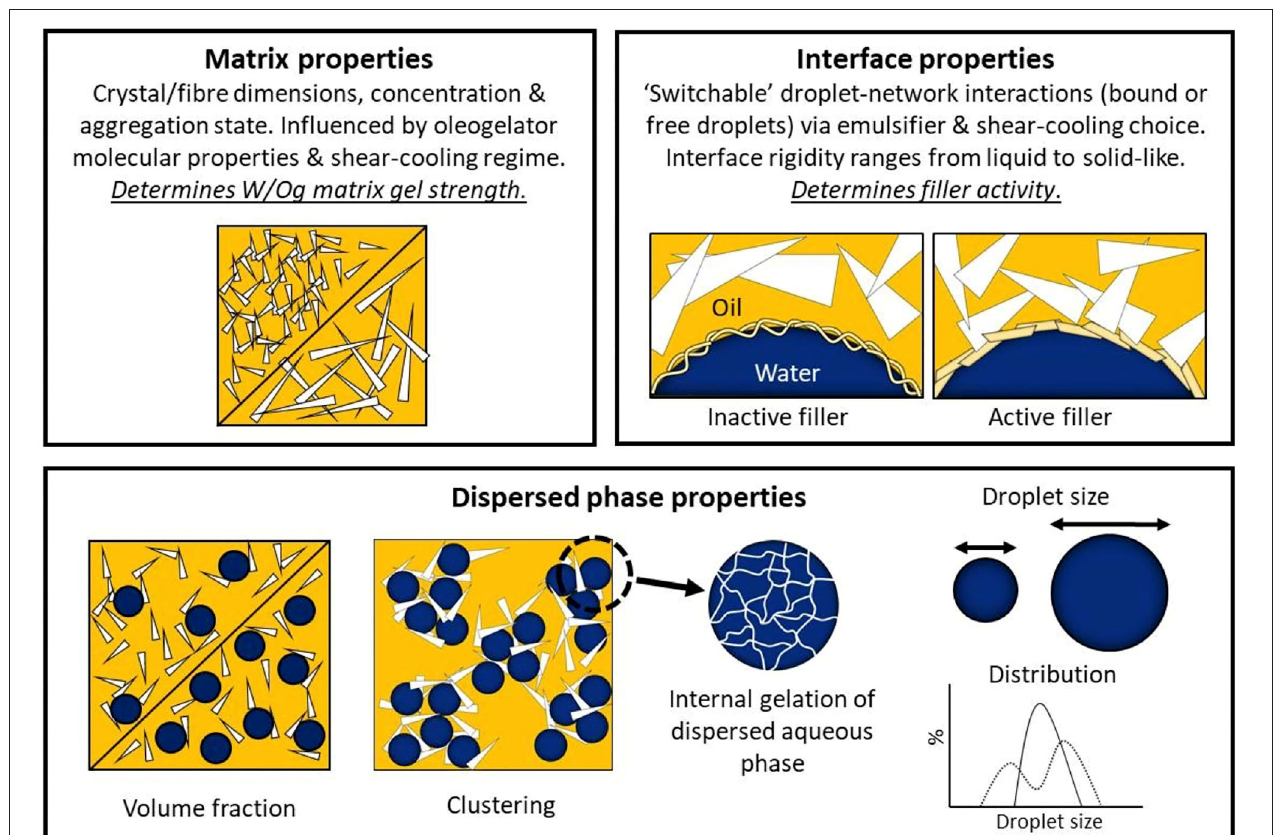
FIGURE 1 | Major factors to consider in the design of water-in-oleogel systems.